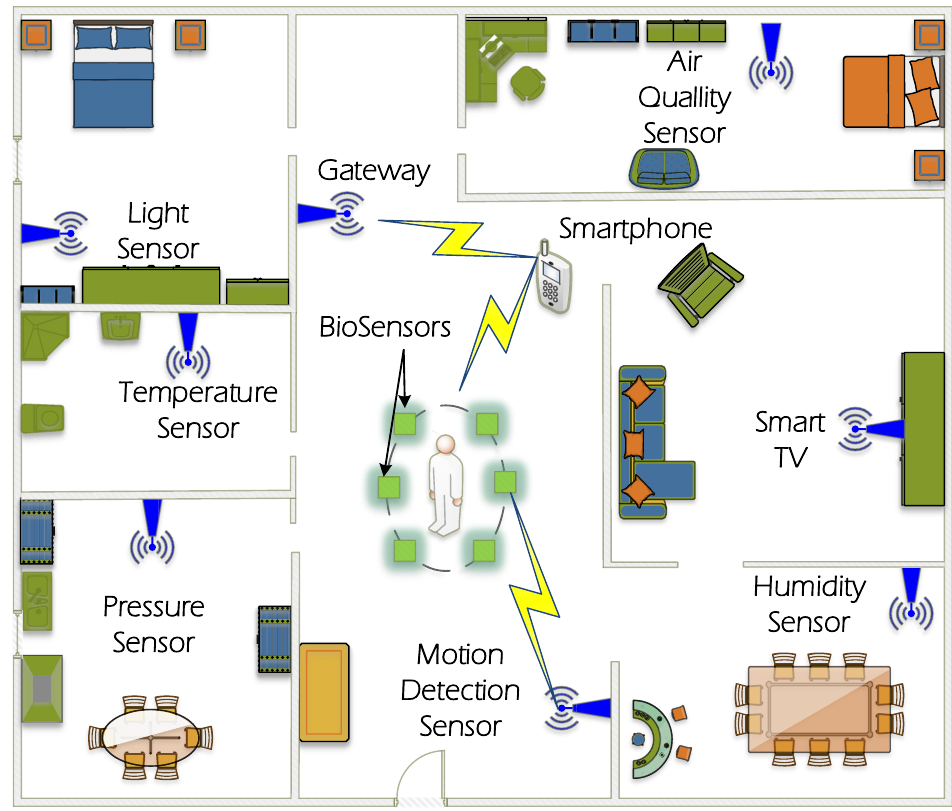
Figure 1. IoT devices are implemented in e-health environments for different monitoring purposes. Therefore, the existence of attackers that disrupt the 2.4 GHz ISM Band expose several risks to IoT